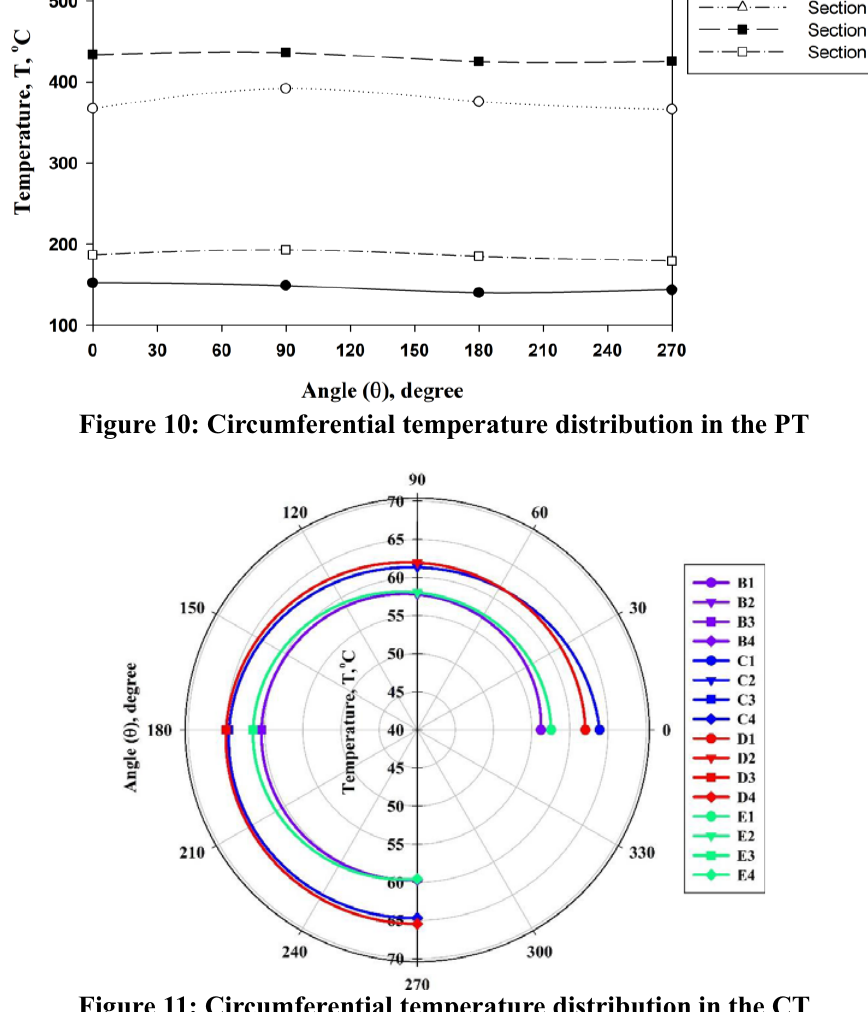
Figure 11: Circumferential temperature distribution in the